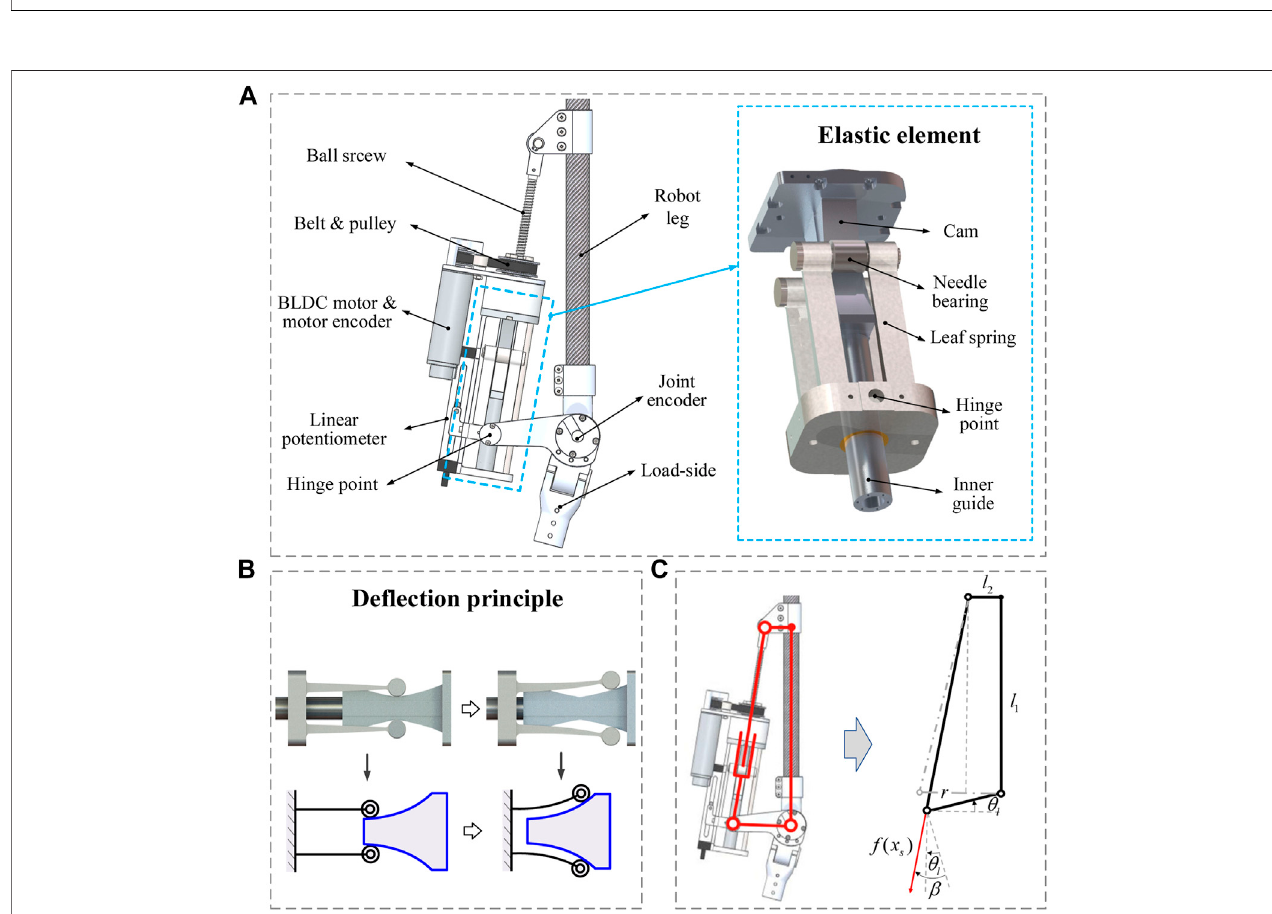
FIGURE2| Load-adaptivevariablestiffnessactuator. (A) ComponentsoftheLaVSAmodel. (B) Leafspringde fl ectionprinciple. (C) MechanismdiagramofLaVSA.